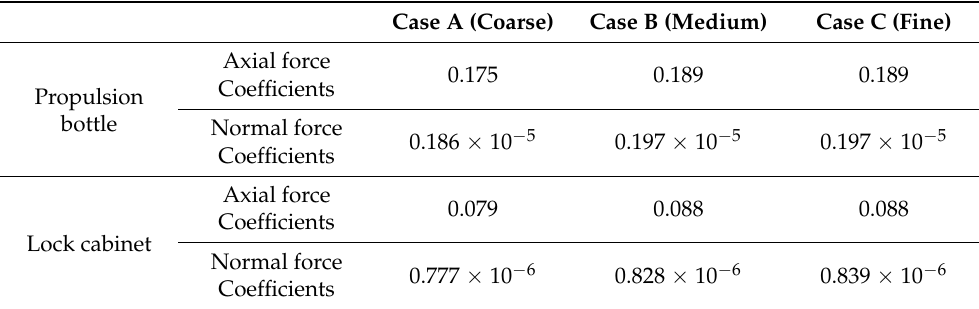
Figure 7. Models used in experiment on flows around debris in near space.